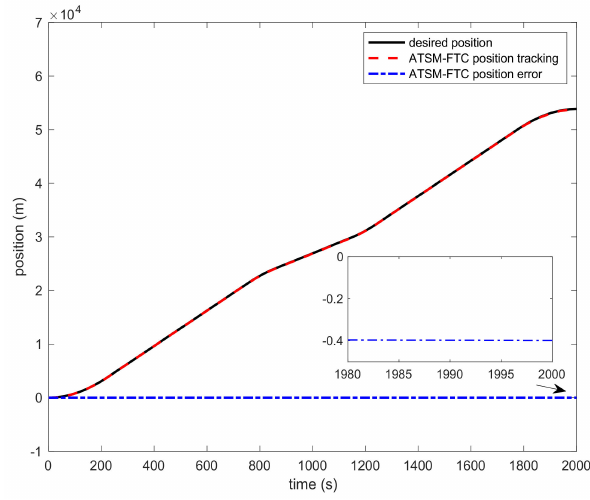
Figure 9. Position tracking performance of ATSM-FTC.